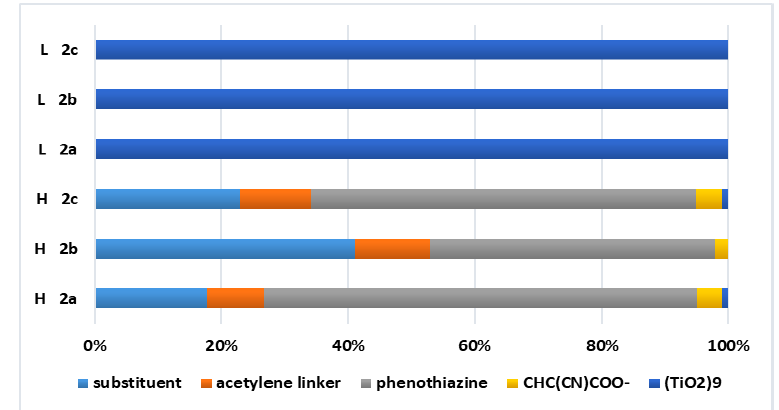
Figure 3. The contributions of particular parts of systems 2a–2c/(TiO 2 ) 9 to the creation of frontier